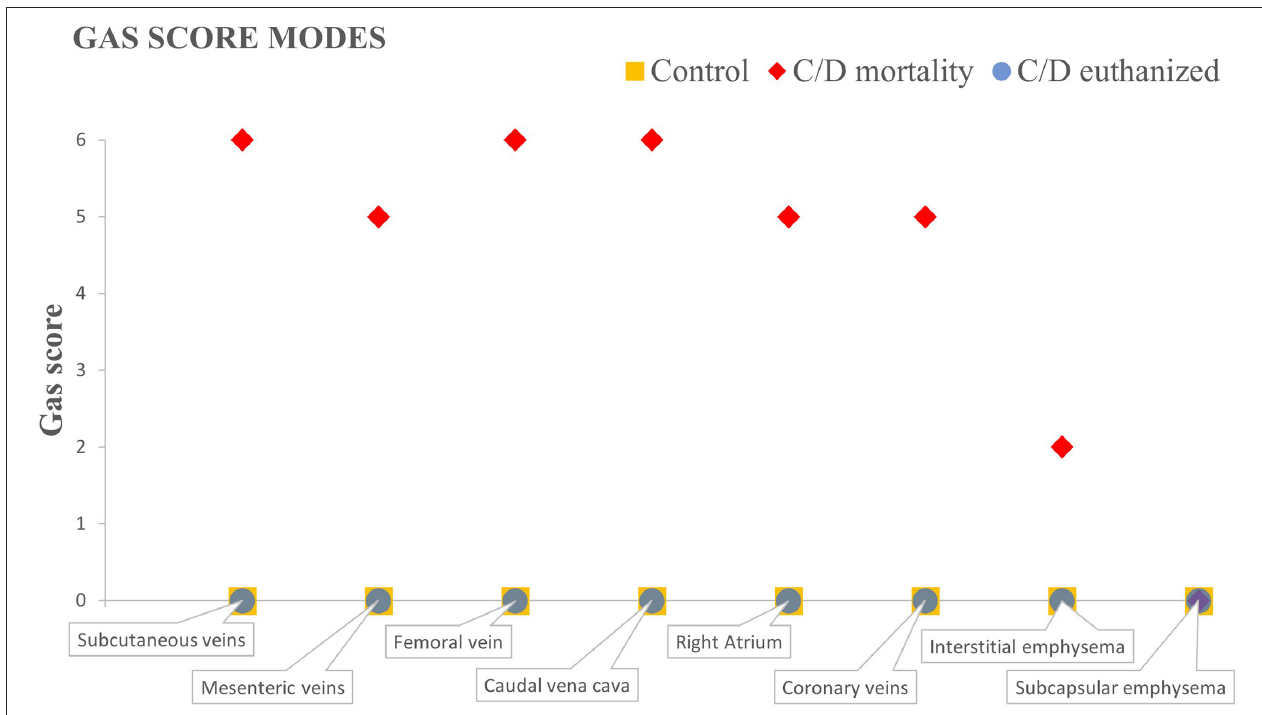
FIGURE 1 | Gas score modes of C/D mortality animals, C/D euthanized animals, and control group in the different locations selected.